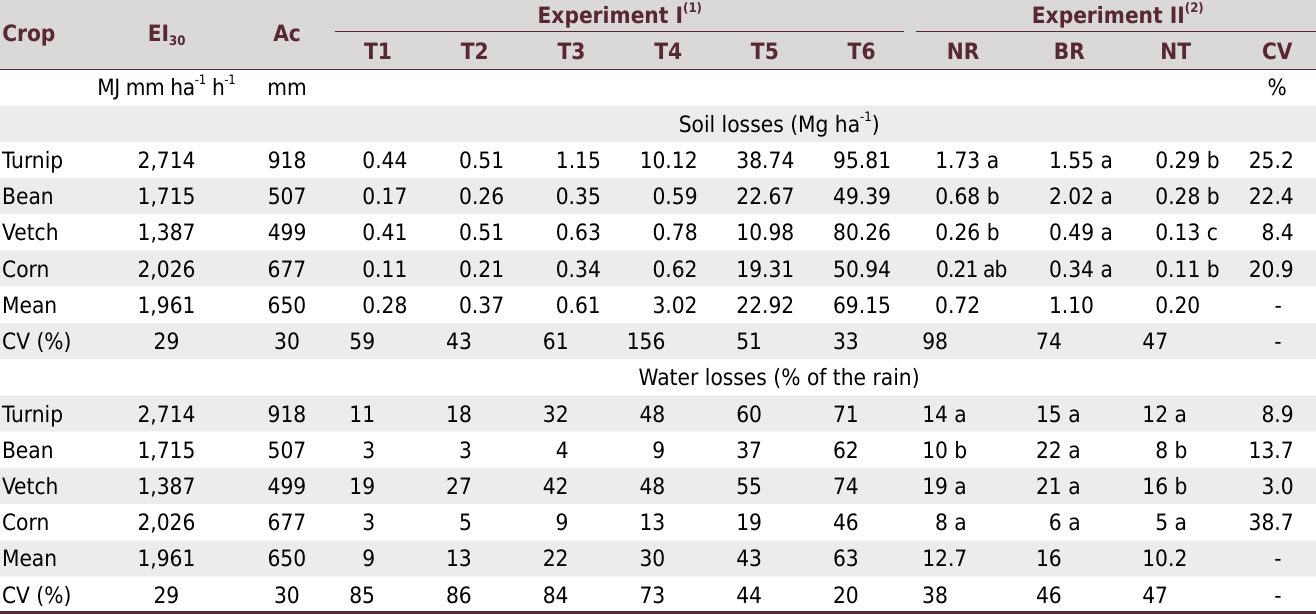
Table 4. Erosivity (EI 30 ) and accumulation (Ac) of the rain, soil losses, and water losses during the crop seasons (Crop) of the treatments of experiments I and